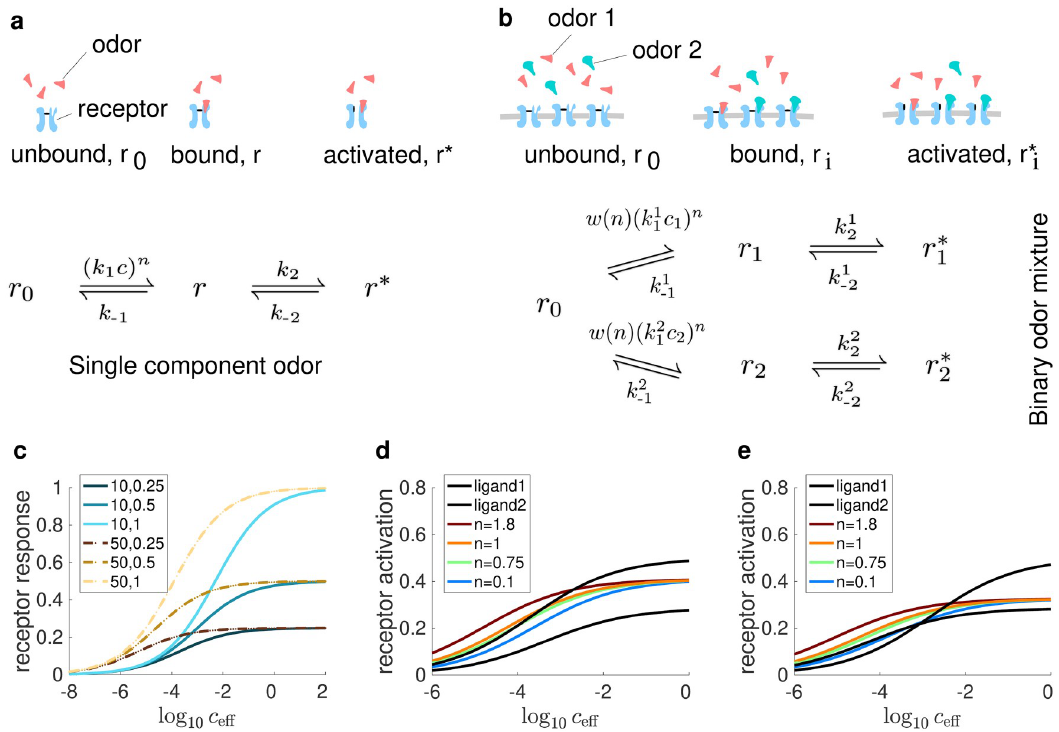
Fig 1. Analysis of the steady state receptor activation in our model for single odorants and mixtures at different concentrations. (a-b) Illustration for our model of binding of odor molecules to olfactory receptors and the activation process of the receptors for (a) single odorants (b) binary mixtures. (c) The receptor activation, r � , as described by Eq 3. In the limit of small c eff , receptors with the same K eff are activated to the same degree, regardless of the value of K 0 . In the limit of large c eff , receptor activation 2 always approaches an asymptotic value depending on K 0 , regardless of the value of K eff . Legend format: 1 st number: K eff , 2 nd number: 2 . (d-e) Examples of the response to binary mixtures as n varies. The activation in response to their constituent components are K 0 2 shown in black lines. In the limit of small c eff , receptor activation for mixtures can be synergistic, hypoadditive or suppressive depending on the values of n . In the other limit, the fraction of activated receptors for mixtures is independent of the value of n and always in between the fraction of activated receptors in response to the constituent components. In (d), component 1: K 0 ¼ 0 : 29 , 2 ¼ 0 : 5 , K eff = 20. In (e), component 1: K 0 ¼ 0 : 5 , K eff = 8.33; component 2: K 0 ¼ 0 : 29 , K eff = K eff = 8.33; component 2: K 0 2 2 2